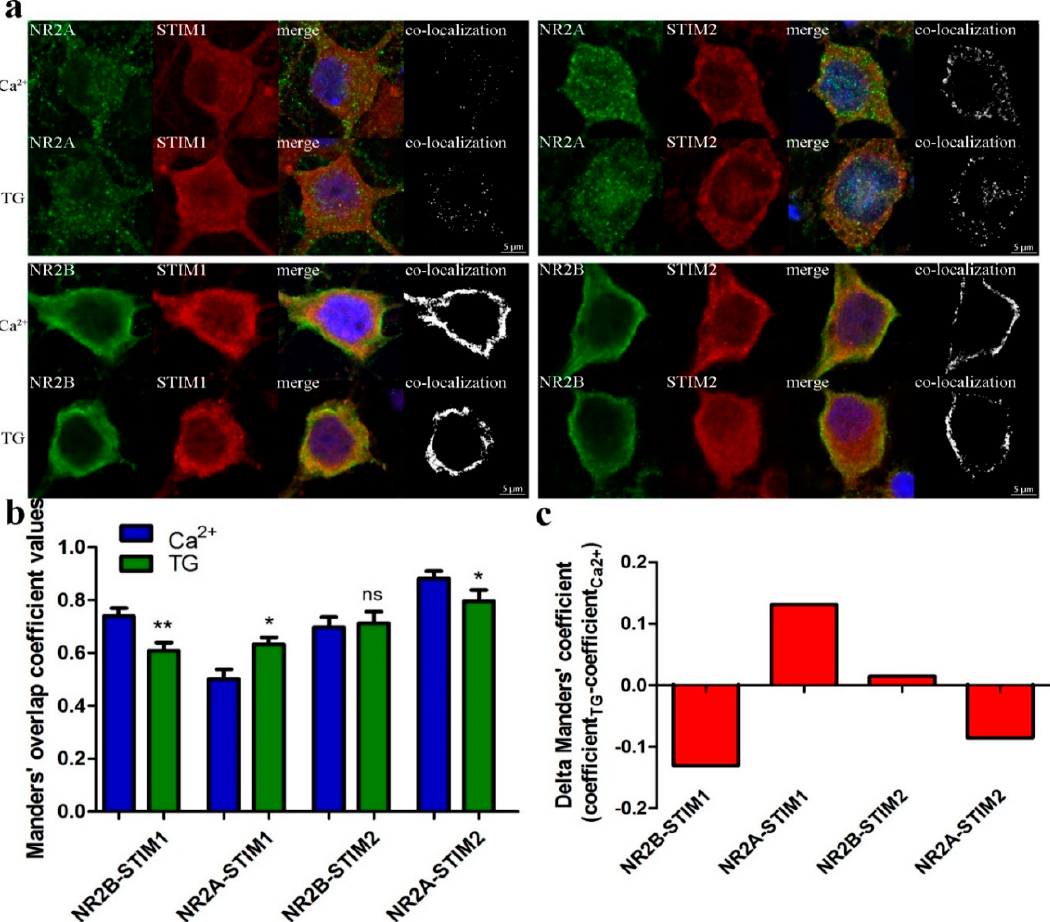
Figure 6. Endogenous STIMs co-localize with NMDAR2. ( a ) Representative confocal images of Ca 2+ or TG/EGTA-treated neurons fixed and stained with anti-NR2A or NR2B antibody (shown in green, 1st panels), with anti-STIM1 or anti-STIM2 (shown in red, 2nd panels) and with anti-MAP2 to identify neurons for analysis (not shown for clarity). (Blue) Nuclei were stained with Hoechst. The 3rd columns show the merged images of green, red and blue channels. Co-localization of NR subunits with STIM is shown in the 4th columns (white). All images are taken from a single slice from the middle of the cell. Scale bar, 5 µm for each panel. ( b , c ) Results of co-localization analysis of NRs with STIMs in soma of neurons treated as in ( a ). Bar graph depicting the quantification of the average value of STIM with NR co-localization coefficient according to Manders ( b ) or the difference between this coefficient value 10 min after TG treatment and before store depletion (in the presence of 2 mM Ca 2+ ) ( c ). * p < 0.05; ** p < 0.01; ns , not significant compared with the control (Mann-Whitney U test). Bars represent the average of cultures from three animals; 35–55 cells per each condition (Ca 2+ or TG/EGTA).